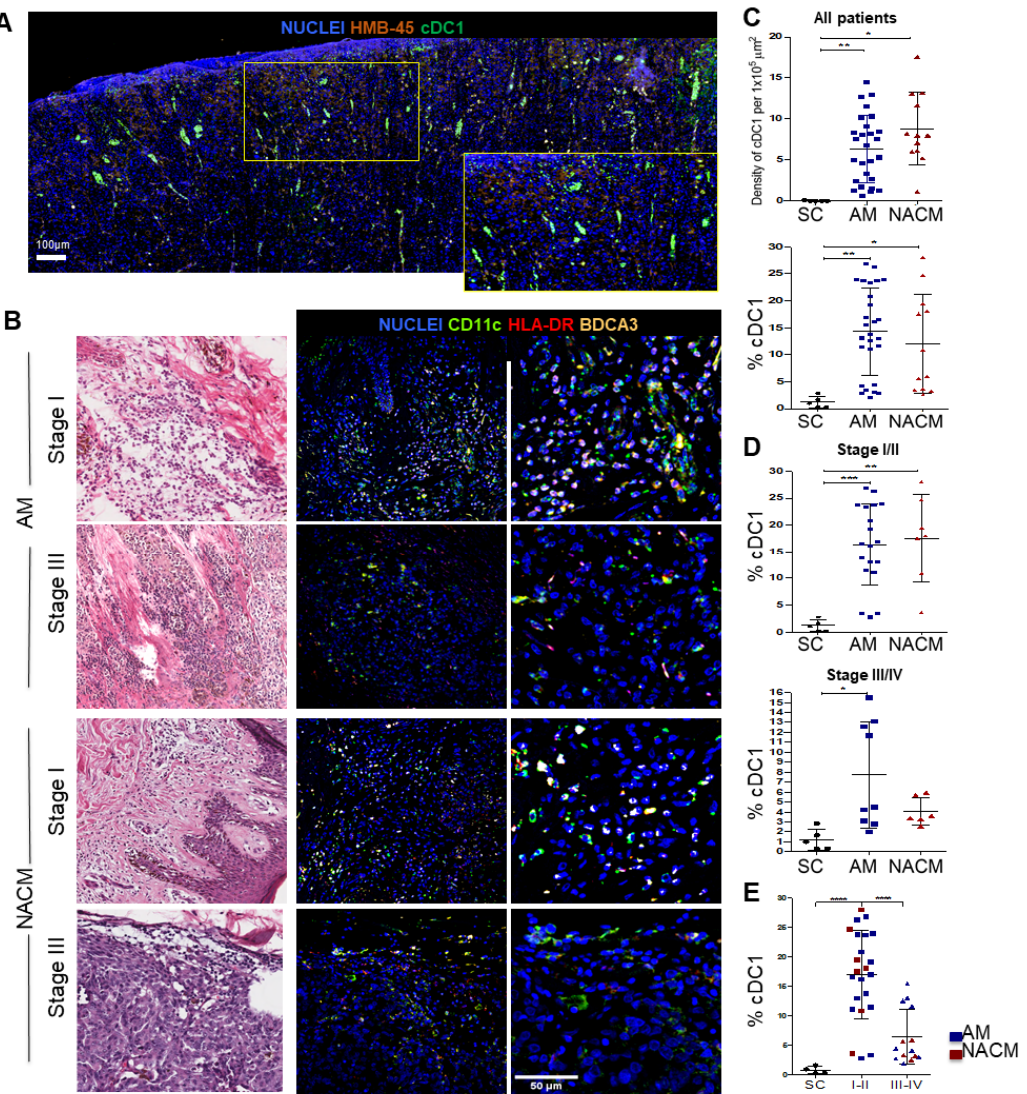
Figure 2. Assessment of the melanoma infiltrating conventional type 1 dendritic cells (cDC1). ( A ) Whole slide scanning of a representative advanced stage III acral melanoma (AM) showing the global distribution of CD11c + HLA-DR + BDCA3 + cDC1s (green) near the HMB-45 + tumor cells (orange). Digital zoom is also presented for a better appreciation (yellow panel). ( B ) Representative hematoxylin & eosin (left column) and immunofluorescence (IF) (middle and right columns) images of stage I and III AM and non-acral cutaneous melanoma (NACM). The right column represents a digital zoom of a highly infiltrated area. IF images were stained with CD11c (green), HLA-DR (red), BDCA3 (yellow) and Nuclei (Blue). ( C , D ) Plots with the following comparisons between AM and NACM, ( C ) the absolute numbers of cDC1s per 1 × 10 5 µ m 2 (top) and percentages of cDC1s (bottom); ( D ) early stages I and II (top) and advanced stages III and IV (bottom). ( E ) Plot comparing the percentage of cDC1s between early and advanced stages. Percentages of cDC1s were estimated among all nucleated cells in the highly infiltrated areas selected. Supplementary Figure S1 shows the autofluorescence control for this experiment. For this analysis, we used 38 samples from the IMSS cohort plus five advanced NACM samples from other hospitals: AM (blue, n = 30) and NACM (red, n = 13). Healthy skin control (SC) samples were obtained from surgical resections unrelated to cancer (black; n = 8). Statistical analysis: One Way ANOVA’s test with Tukey’s post hoc test for multiple comparisons. * p < 0.05, ** p < 0.01, *** p < 0.001, and **** p <